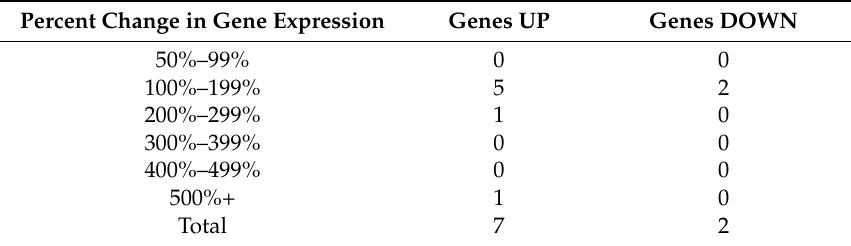
Table 2. Distribution of Genes Affected by GHK and Associated with Pain.